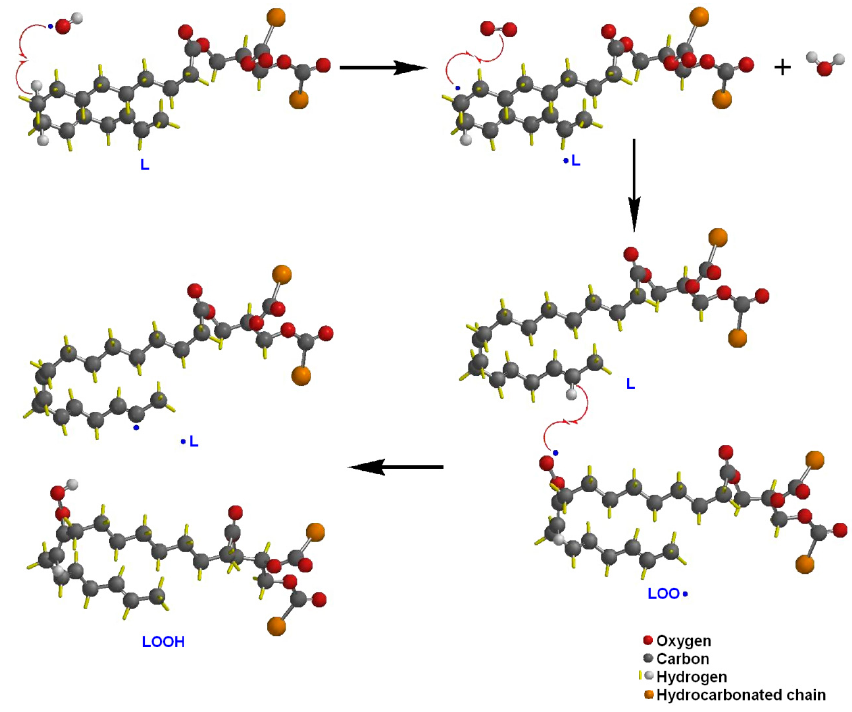
Figure 1. Oxidation reaction mechanism by hydroxyl radicals of an unsaturated lipid (L).